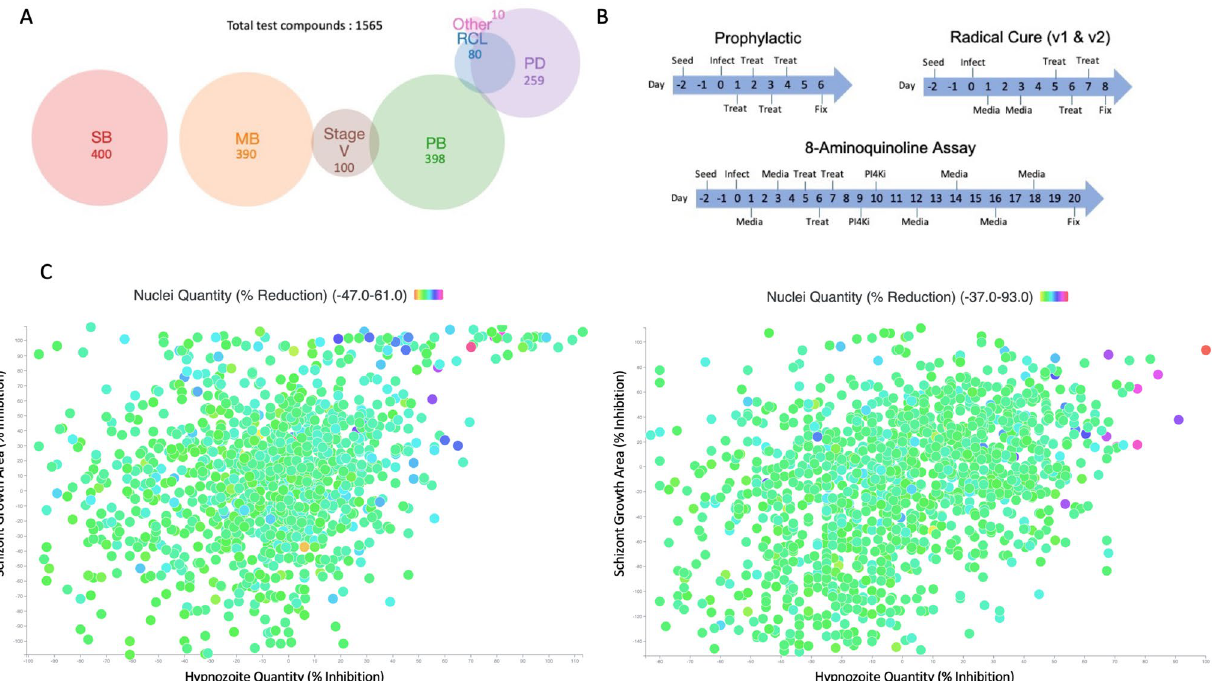
Figure 1. Library contents, assay workflow, and Single Point data summary. ( A ) Venn diagram of all compounds tested, grouped by library. RCL, Reference Compound Library; PB, Pathogen Box; SB, Stasis Box; MB, Malaria Box; PD, Photodiversity Library. ( B ) Summary of assay workflow for Prophylactic and Radical Cure modes as well as a newly-developed 20-day assay to assess activity for 8-aminoquinolines. Media indicates media change, Treat indicates a media change followed by treatment with compounds via pin tool, PI4Ki indicates addition of 1 μM MMV390048 added to the culture during media change. ( C ) All SP data from the highest-quality Prophylactic runs (left) and 8-day Radical Cure runs (right). X-axis represents inhibition of hypnozoite quantity, Y-axis represents inhibition of schizont growth, color represents reduction of hepatic nuclei, likely due to toxicity. For nuclei reduction, green and blue represent little or no loss of nuclei (< 10%), deep blue represents some loss of nuclei (10–30%), purple and red represent dramatic loss of nuclei (> 30%). Control well data were removed for better